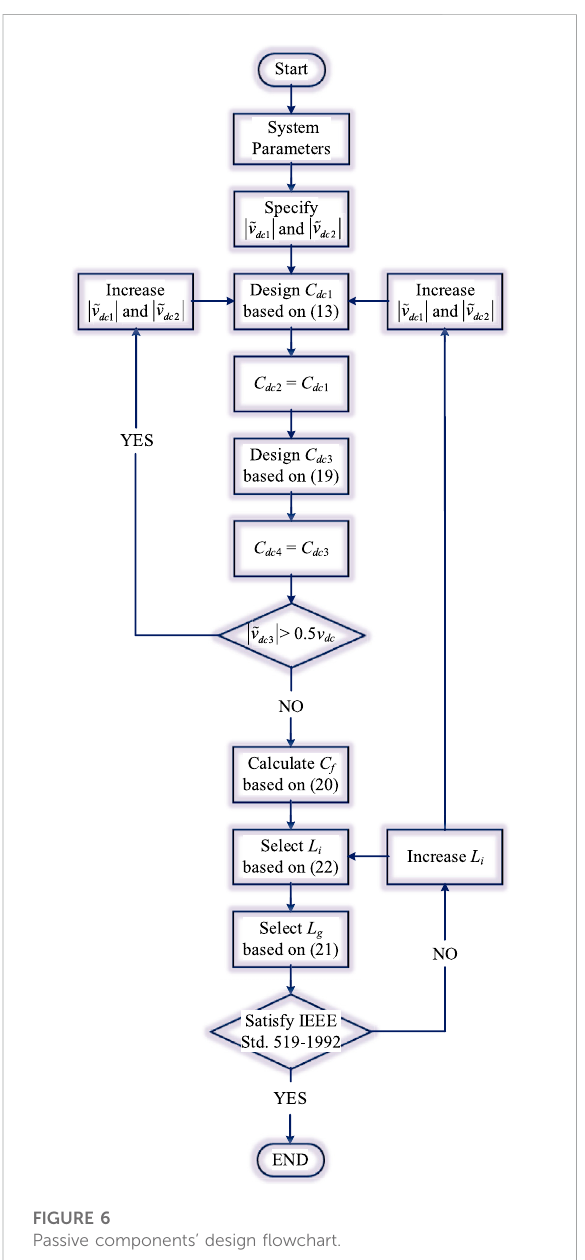
FIGURE 6 Passive components ’ design fl